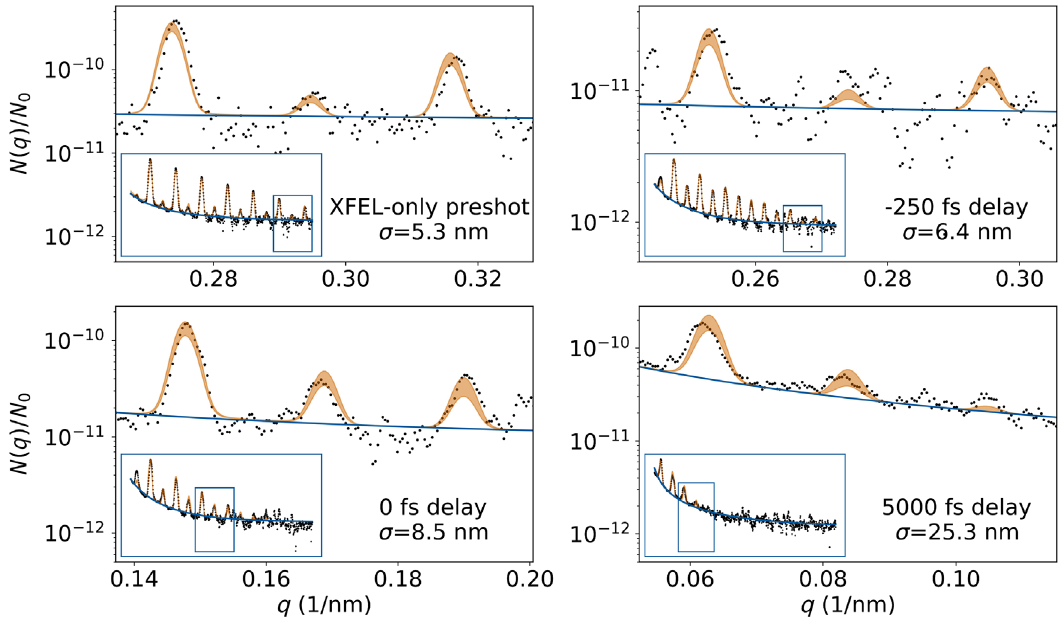
FIG. 7. Lineouts of scattered intensity normalized to the XFEL intensity (black points) taken along the q direction perpendicular to the grating ridges, averaged over 20 pixels, the same as shown in Fig. 2. The reminiscent background was modeled by a power law (blue line) and subtracted prior to the fit. The regions shown are a zoom into the lineout as marked in the respective insets in order to make visible the shaded area for the relevant peaks at large q values. They represent the range of possible fits with a χ < 1 . 01 χ